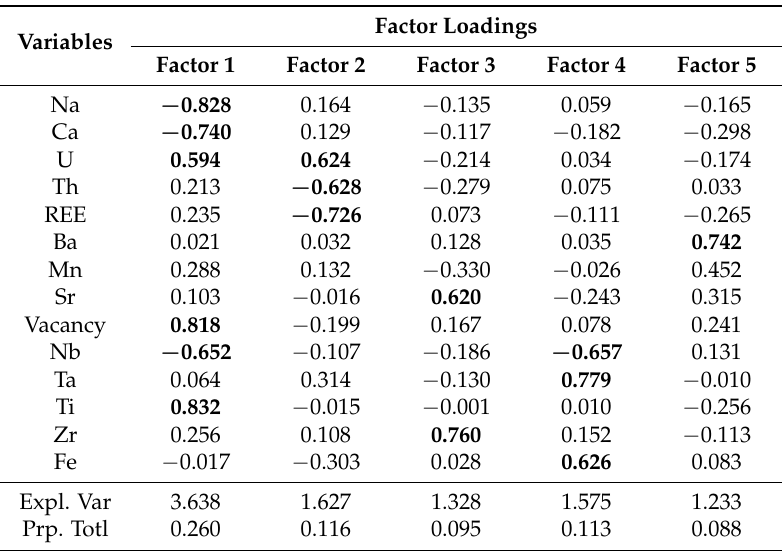
Table 5. Result of factor analysis of PSM composition.